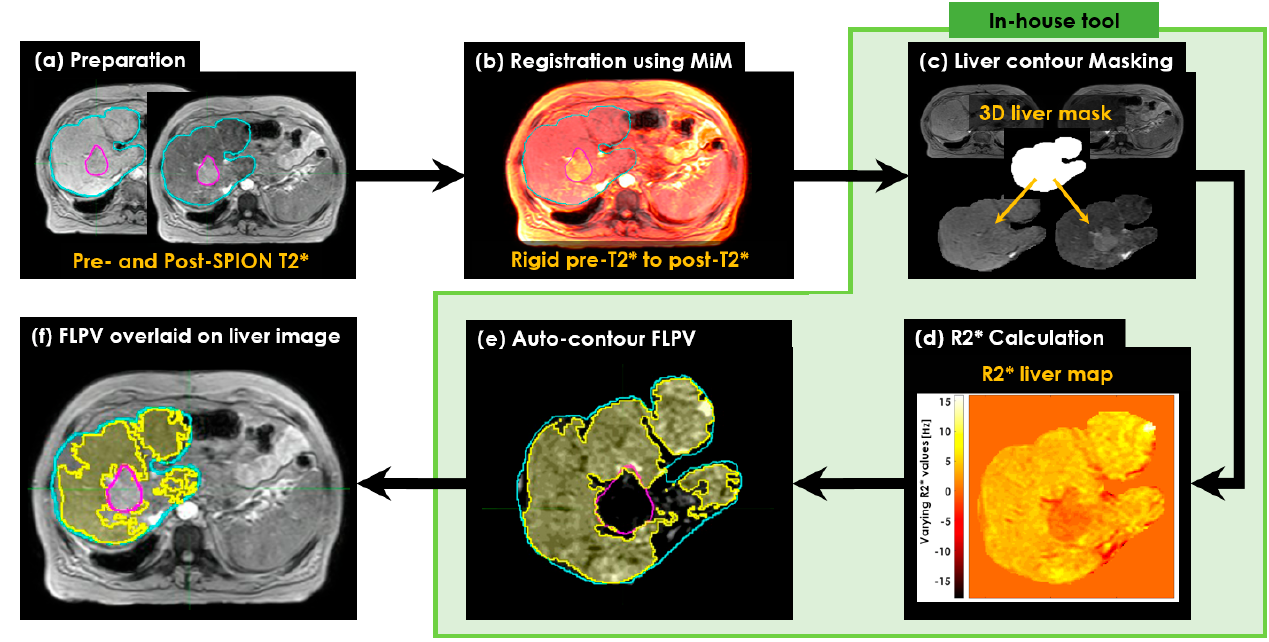
Figure 1. The workflow of characterizing FLP and non-FLP in the R2* liver map. ( a ) Preparation of pre- and post-SPION T2* image sets; ( b ) registration of the two pre- and post-SPION T2* image sets to copy the liver (Cyan color) and tumor (Magenta color) contours manually identified by a physician; ( c ) masking the liver contour to extract the corresponding liver volume in voxels; ( d ) calculation of R2* relaxation rates; ( e ) auto-contouring FLPV colored area in yellow; and ( f ) overlaid FLPV on liver image to evaluate the efficiency of an auto-contouring tool for further sparing of healthy tissues during radiotherapy and liver resection.